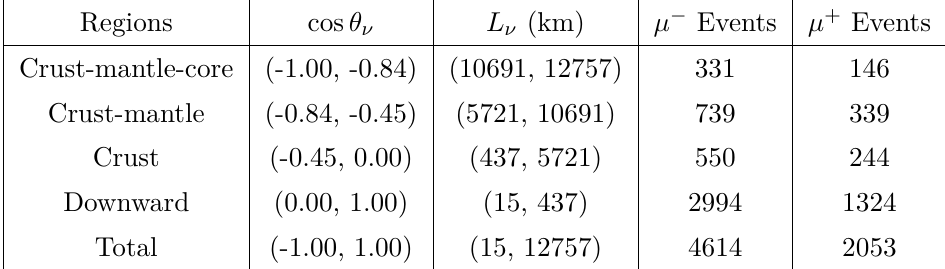
Table 4 . Reconstructed µ − and µ + events expected at ICAL for 500 kt · yr exposure for neutrinos passing through various regions depending upon zenith angle of neutrino. These reconstructed muon events for 10 years are scaled from 1000-year MC data. We consider three-flavor neutrino oscillations in the presence of matter with the PREM profile. We take the three-flavor oscillation parameters from table 2. We assume NO and sin 2 θ = 0 . 5 23